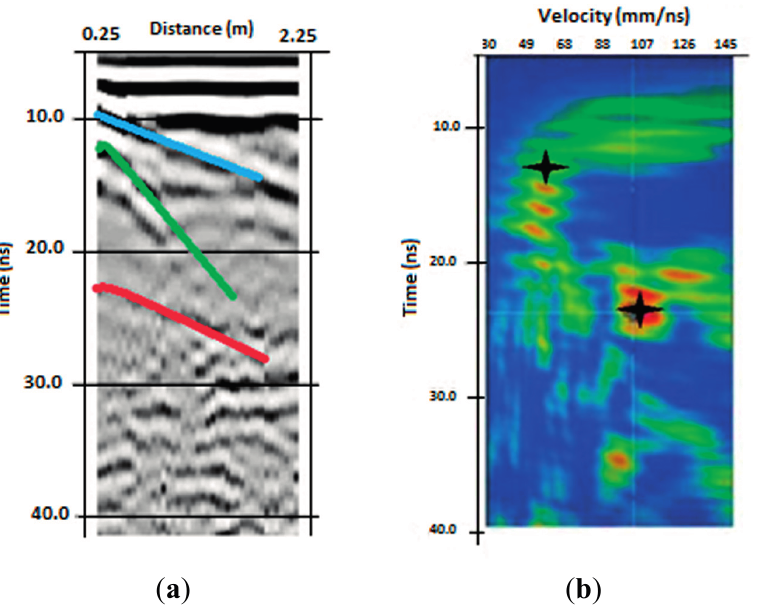
Figure 4. Example of CMP measurements: time section after a basic processing ( a ) and velocity spectrum ( b ). In ( a ) the colored lines represent the air wave (light blue), the second reflection (green) and the bedrock reflection (red). In ( b ) the colors, from blue to